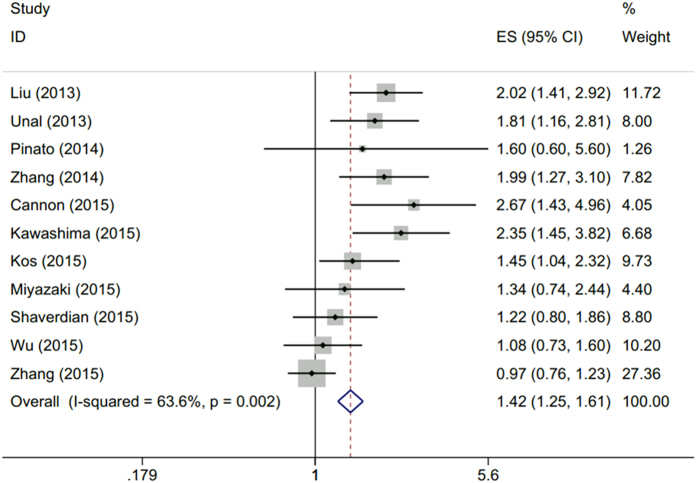
Forest plot of the association between PLR and OS in patients with NSCLC.